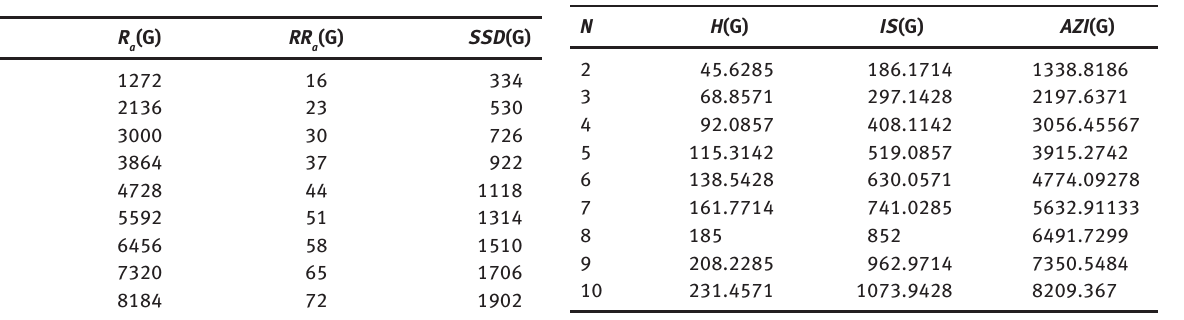
( n ), 1 Table 10: Comparison among H (G), IS (G), and AZI (G) of MON